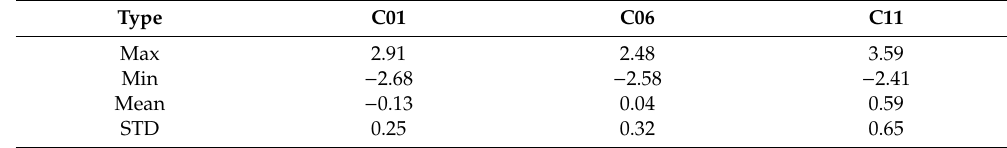
Table 3. Statistics of BDS real-time partition correction time series for C01, C06, and C11 (in meter).